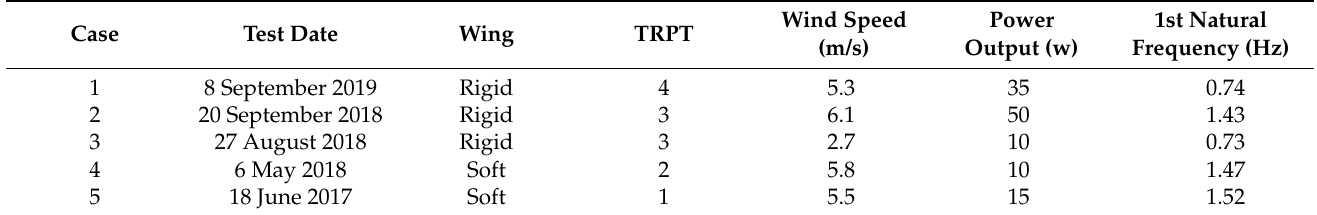
Table 1. Five experiments used for comparison with the mathematical